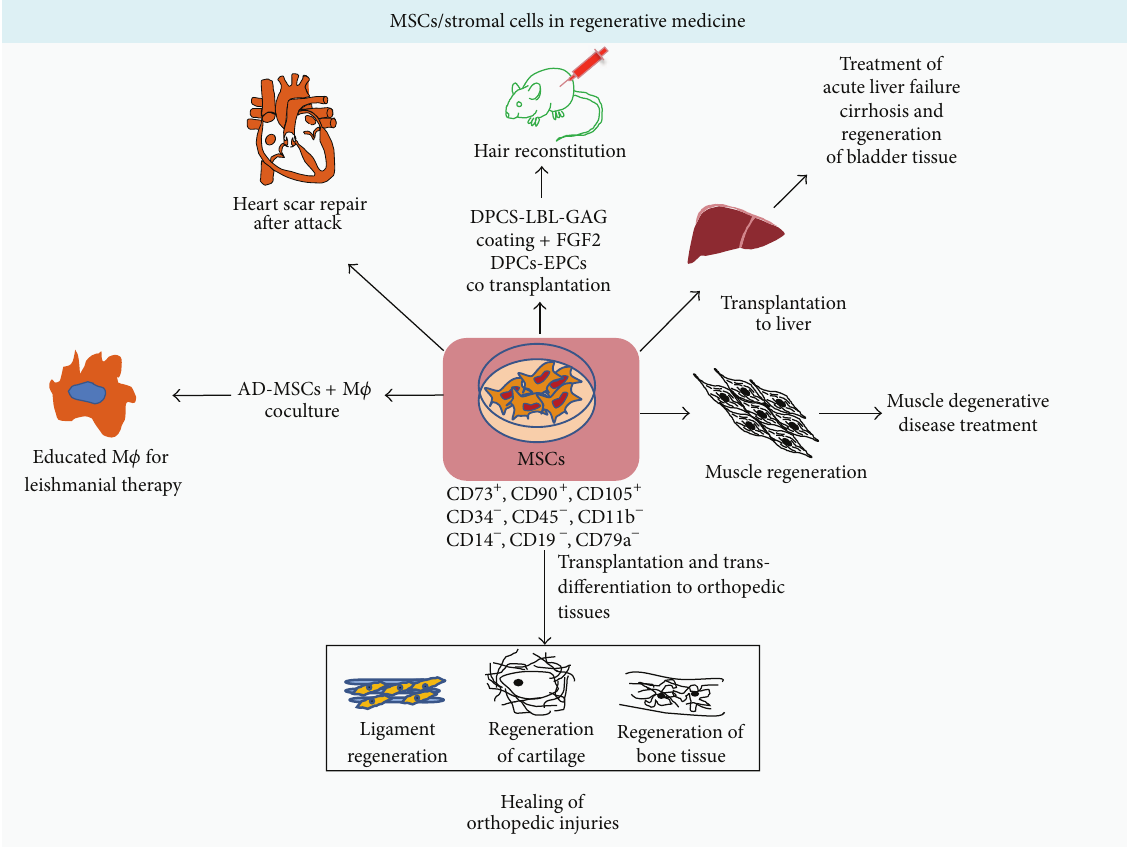
Figure 4: MSCs in regenerative medicine: mesenchymal stem cells are CD73 + , CD90 + , CD105 + , CD34 − , CD45 − , CD11b − , CD14 − , CD19 − , and CD79a − cells, also known as stromal cells. These bodily MSCs represented here do not account for MSCs of bone marrow and umbilical cord. Upon transplantation and transdifferentiation these bodily MSCs regenerate into cartilage, bones, and muscles tissue. Heart scar formed after heart attack and liver cirrhosis can be treated from MSCs. ECM coating provides the niche environment for MSCs to regenerate into hair follicle, stimulating hair